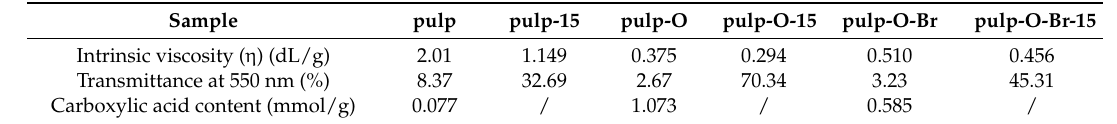
Table 1. Physicochemical properties of